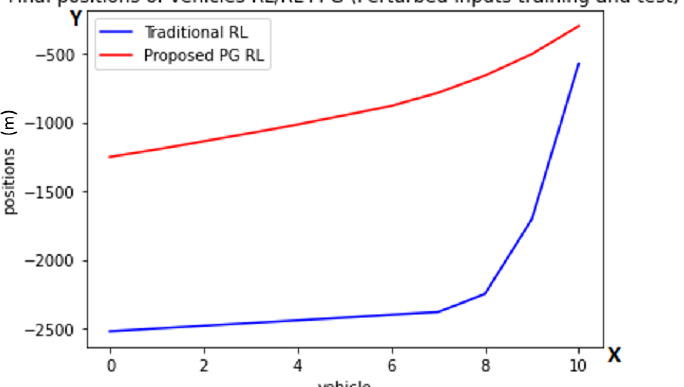
Figure 5. Graph of the finals positions after the first task with randomized inputs using the traditional RL (blue color) and the proposed PG RL (red color) models trained with perturbations. The y -axis is representing the position behind the lead vehicle in meters while one point on the x -axis is referring to exactly one vehicle. These are the average final positions at the end of the scenarios, with the numbers referring to the vehicles (from back to front).